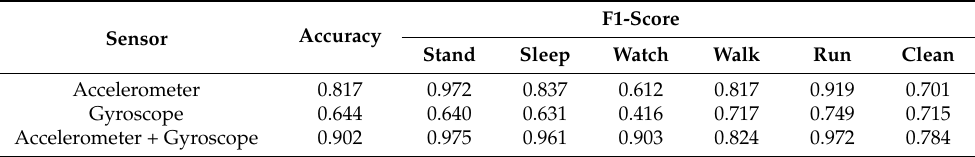
Table 7. Comparison experiments of different sensors without